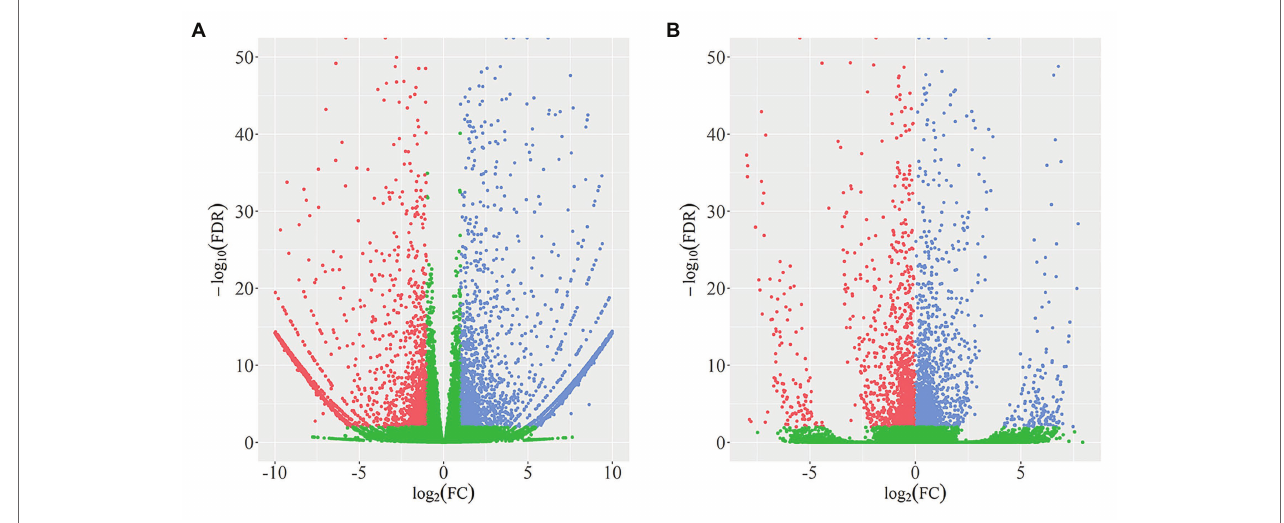
FIGURE 1 | Identification and distribution of differentially expressed genes (DEGs; A ) and differential exon usage (DEUs; B ). Red dots represent DEGs or DEUs with upregulated expression levels in qd , blue dots represent DEGs or DEUs with downregulated expression levels in qd , green dots represent genes or exons without significant differences in expression levels between wild-type and qd